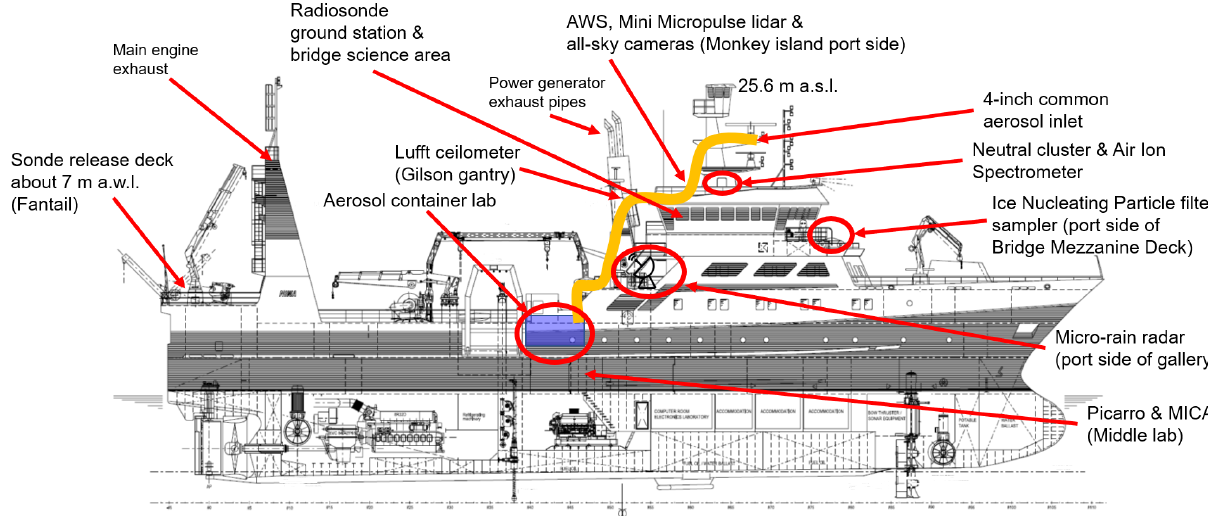
Figure 3. A diagram showing the locations of the atmospheric measurement equipment aboard RV Tangaroa . A line pump for the common aerosol inlet was used to pump sample air from above the bridge to the aerosol container